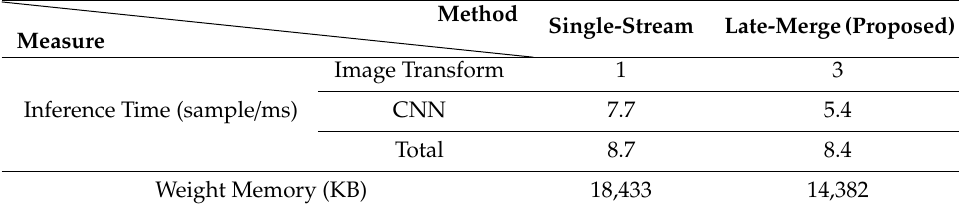
Table 4. Inference time and weight of networks.